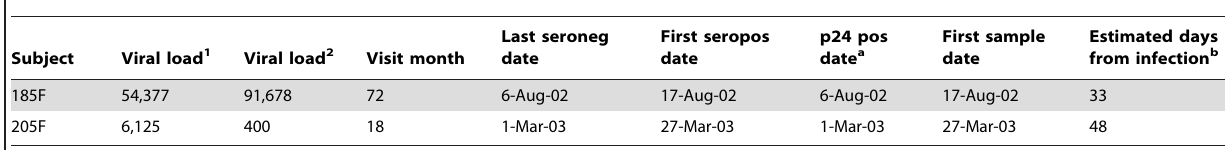
Table 1. Seroconvertors from ZEHRP that were evaluated for Nab